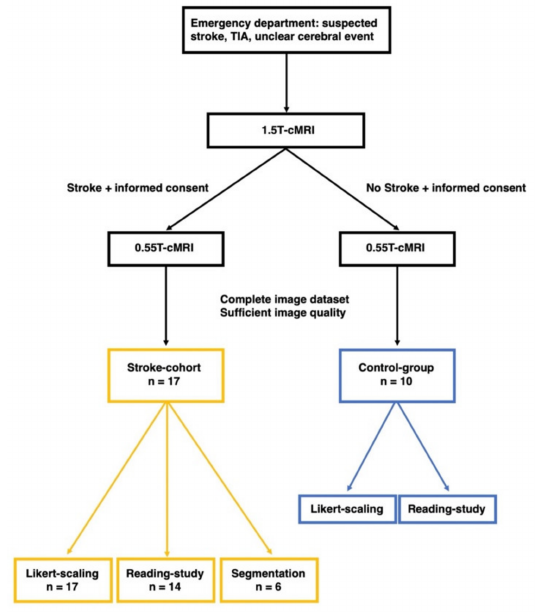
Figure 2. Workflow of data